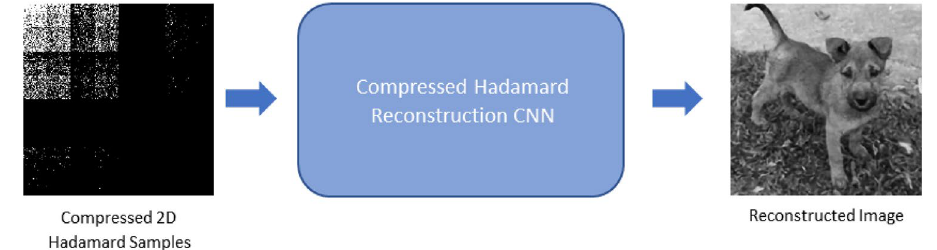
Figure 7. General compressed sensing reconstruction scheme by the means of DL.